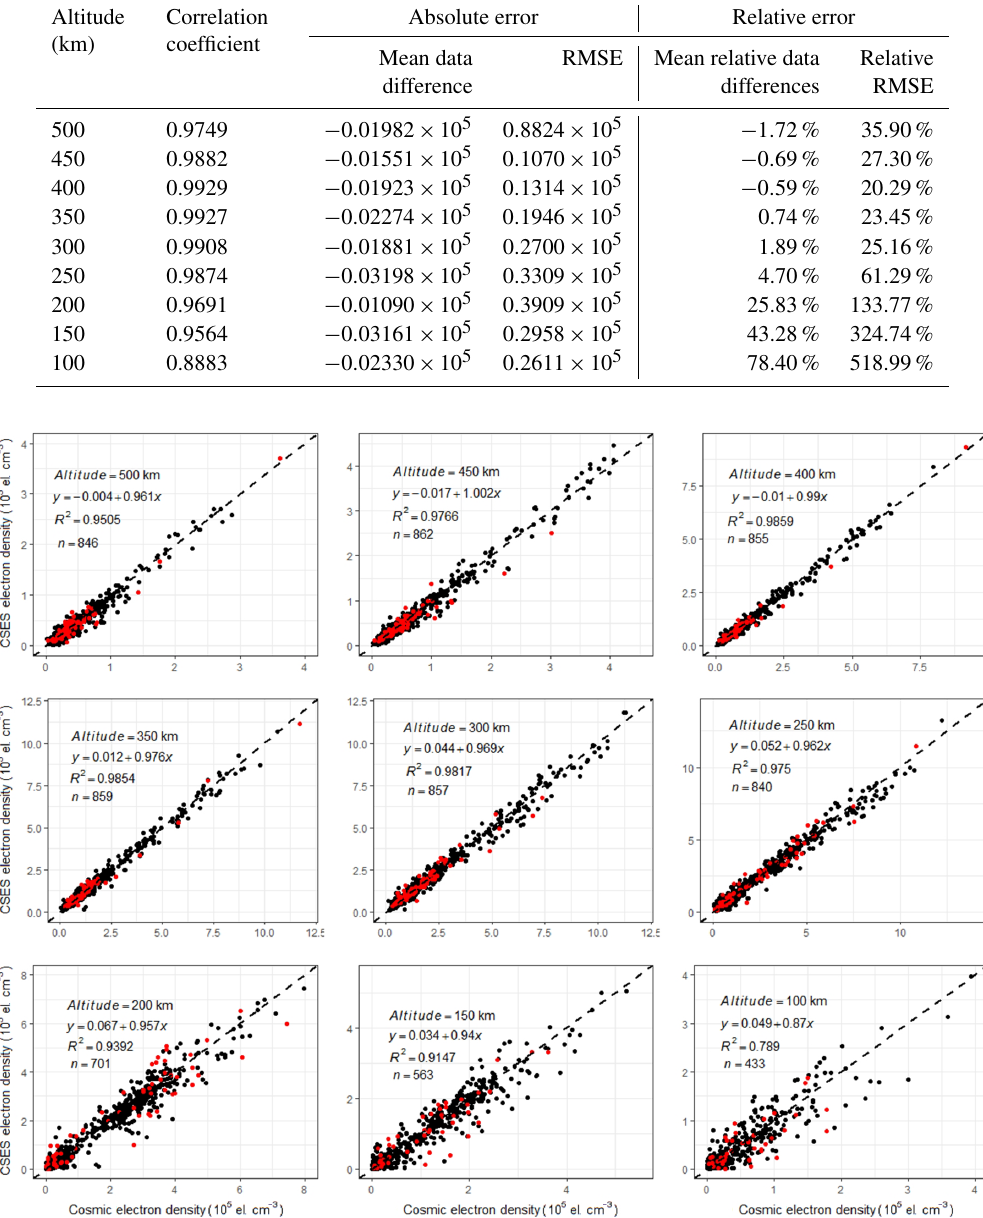
Table 3. Correlation coefficients and RMSEs for the data at different altitudes of the profiles.